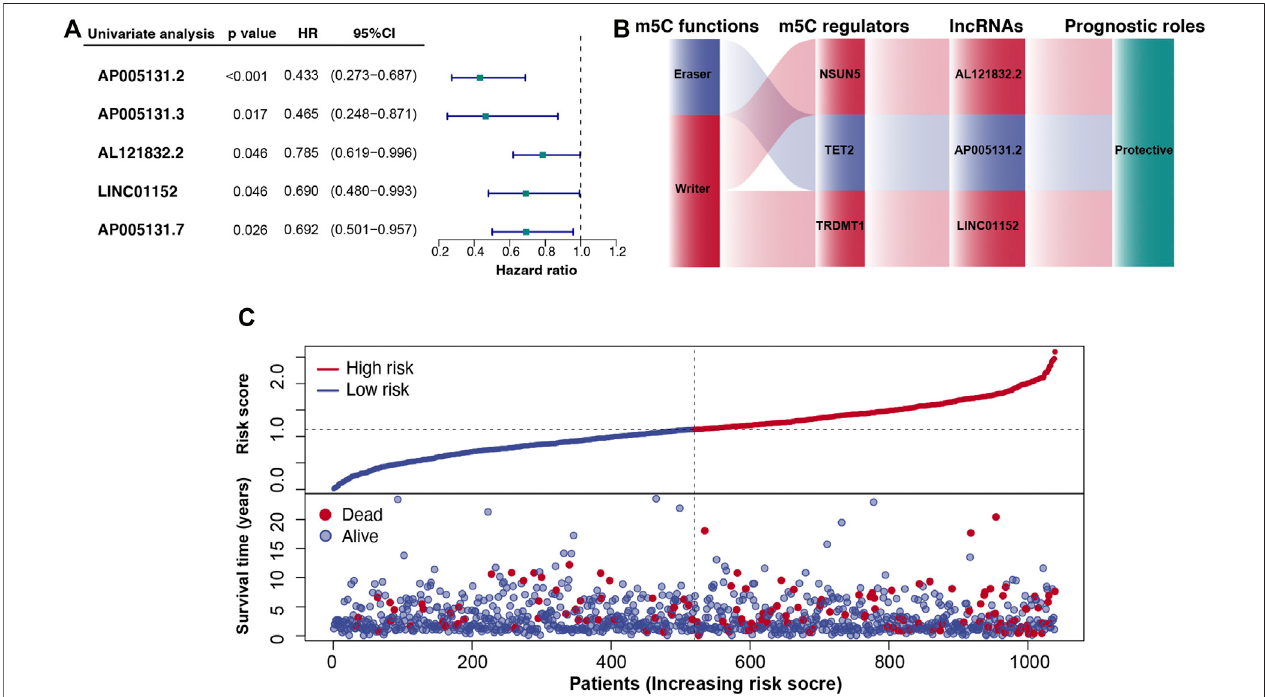
FIGURE 2 | Cancer-speci fi c m5C-lncRNAs and their co-expression networks with m5C regulators in breast cancer (BC). (A) Forest diagram of univariate Cox regression analysis of m5C-lncRNAs. (B) Co-expression networks of the three m5C-lncRNAs screened using multivariate Cox regression analysis. (C) Distributions of risk scores and survival status of patients with BC based on m5C-lncRNA signature from the TCGA dataset.